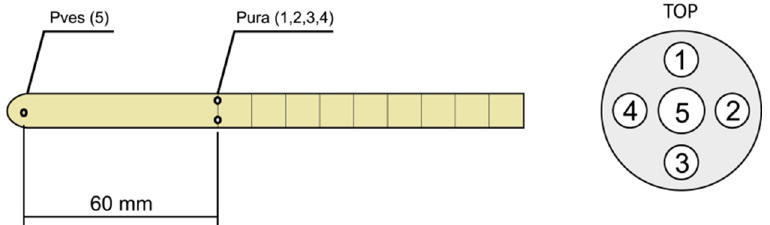
Figure 1. Placement of lumens in catheter 5PPV-9 (P ves- intravesical pressure, Pura-intraurethral pressure, 1–4 -channels numbers).